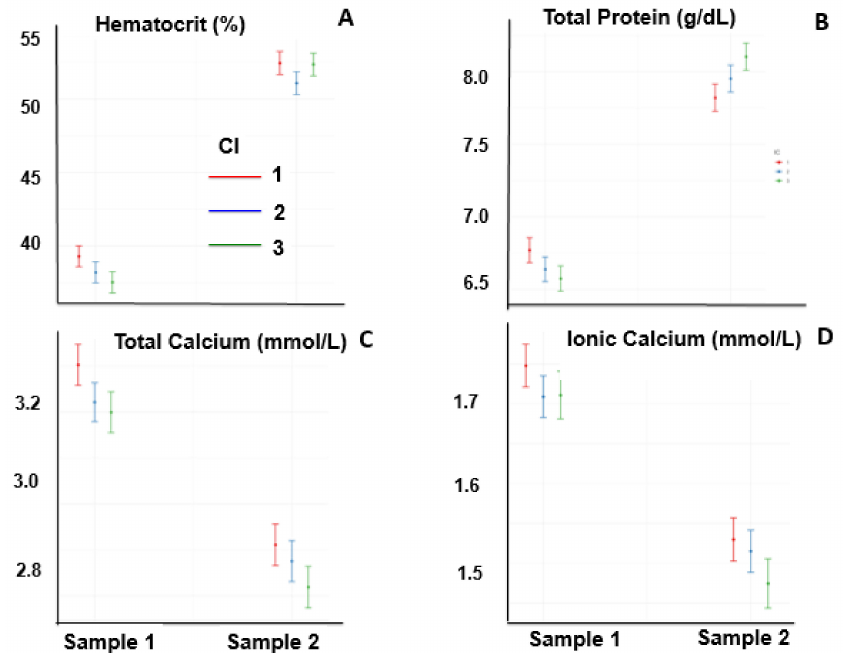
Figure 3. Hematocrit ( A ), total plasma protein ( B ), total calcium ( C ), and ionic calcium ( D ) of horses one day before the race (Sample 1) and at elimination or when they retired from the race (Sample 2). The hematocrit increased at the end of the race ( p < 0.05), and it was not